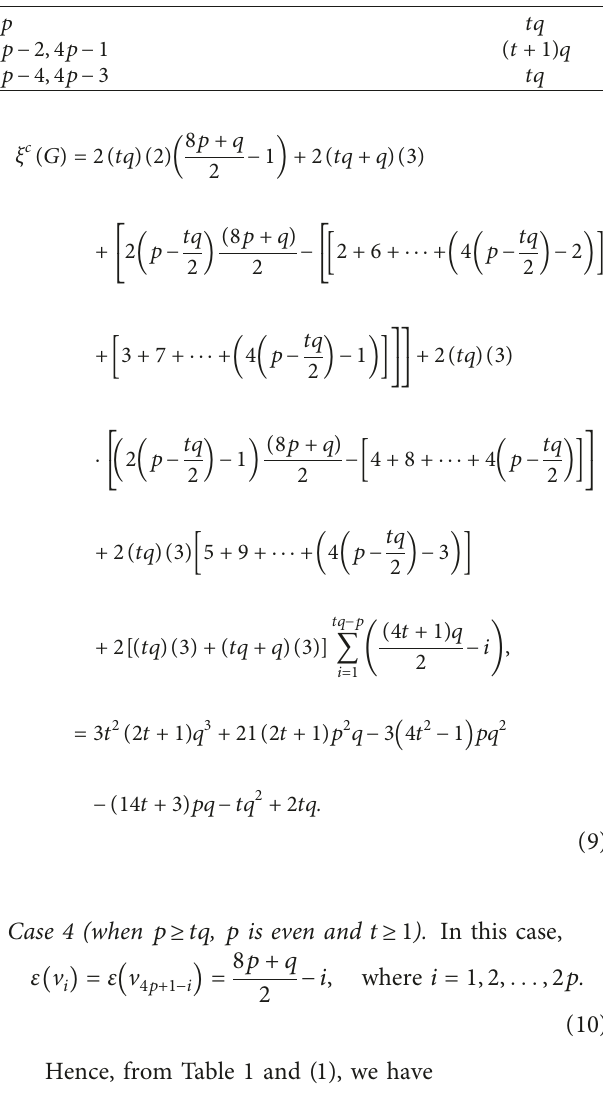
Cardinality for each row